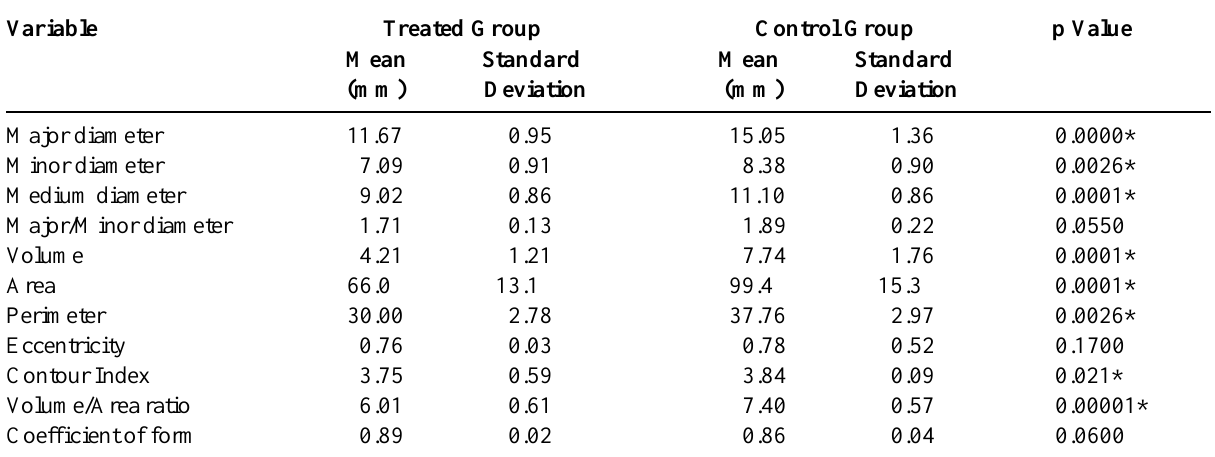
Table 1 – Mean values and standard deviations for the major, medium and minor diameters, volume, perimeter, eccentricity, contour index, volume/area ratio, and coefficient of form of the cell nuclei of the basal layer of the prostate glandular epithelium in both the treated and the control